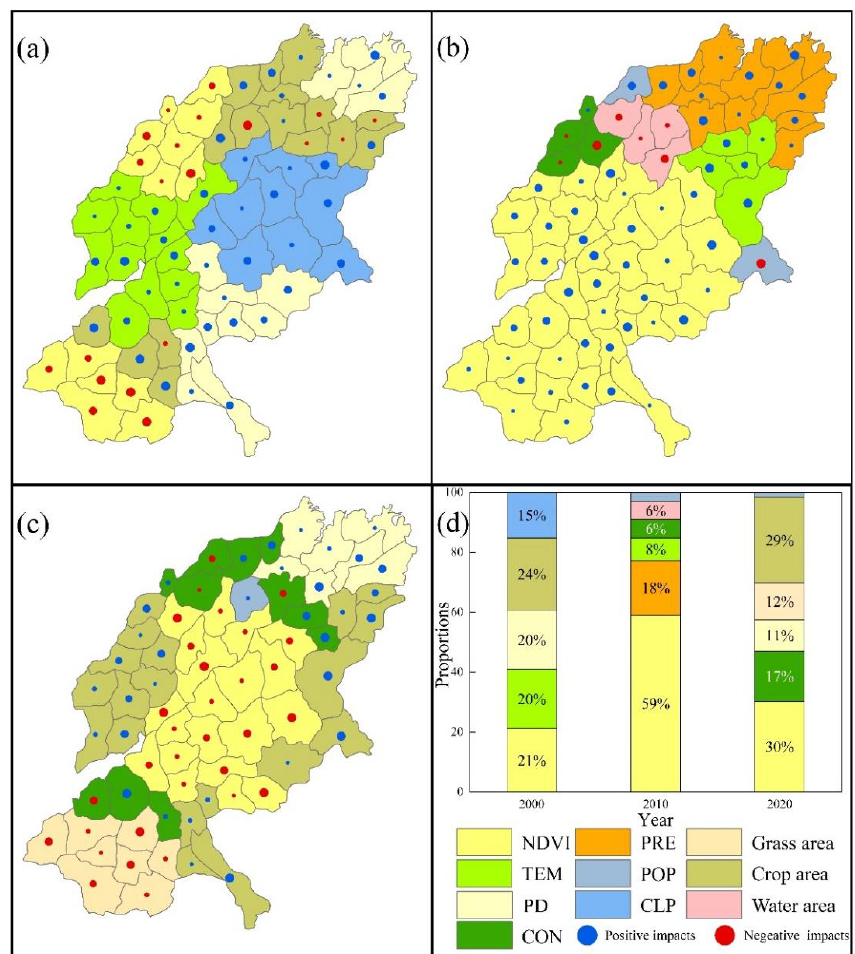
Figure 11. ESs’ trade-off drivers in different cities of FP_CS (( a ) in 2000; ( b ) in 2010; ( c ) in 2020). ( d ) Proportion of area accounted for by key ES trade-off drivers in different years ( Refer to Tables 2 and 3 for the meanings of each symbol ) .